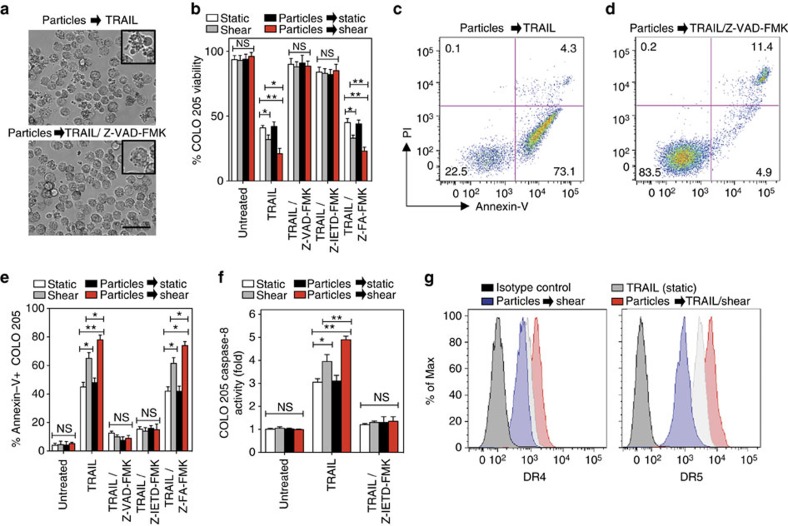
Amplification of TRAIL apoptotic effect via polymeric particles conjugation is caspase dependent and increases death receptor expression.(a) Brightfield micrographs of particle (diameter: 500 nm)-functionalized COLO 205 tumour cells treated with 0.1 μg ml−1 TRAIL under fluid shear stress exposure (shear stress: 4.0 dyn cm−2) for 1 h in the absence and presence of 50 μM pan caspase inhibitor Z-VAD-FMK. (b) Viability of particle-functionalized COLO 205 tumour cells treated with 0.1 μg ml−1 TRAIL under fluid shear stress exposure for 1 h in the presence of 50 μM pan caspase inhibitor Z-VAD-FMK, 50 μM caspase-8 inhibitor Z-IETD-FMK or 50 μM caspase negative control inhibitor Z-FA-FMK. N=4 for all treatments. (c,d) Annexin-V/propidium iodide (PI) flow cytometry plots of particle-functionalized COLO 205 tumour cells treated with 0.1 μg ml−1 TRAIL in the presence of a fluid shear stress for 1 h without and with Z-VAD-FMK treatment. N=4 for all treatments. (e) Annexin-V quantification of particle-functionalized COLO 205 tumour cells treated with 0.1 μg ml−1 TRAIL under fluid shear stress exposure for 1 h in the presence of 50 μM pan caspase inhibitor Z-VAD-FMK, 50 μM caspase-8 inhibitor Z-IETD-FMK or 50 μM caspase negative control inhibitor Z-FA-FMK. N=4 for all treatments. (f) Caspase-8 activity of particle-functionalized COLO 205 tumour cells after treatment with TRAIL (0.1 μg ml−1) in the presence and absence of fluid shear stress for 1 h. N=4 for all treatments. (g) TRAIL death receptor (DR) 4 and 5 expression after treatment of particle-functionalized COLO 205 tumour cells with TRAIL (0.1 μg ml−1) in the presence and absence of fluid shear stress for 1 h. N=5 for all treatments. Data are reported as mean±s.e. Different treatment groups were compared for statistical significance using Student's two-tailed t-test for two conditions and one-way analysis of variance (ANOVA) for multiple comparisons. Percent of max represents the number of events normalized according to FlowJo algorithms. *P<0.05 and **P<0.01. NS, not significant.